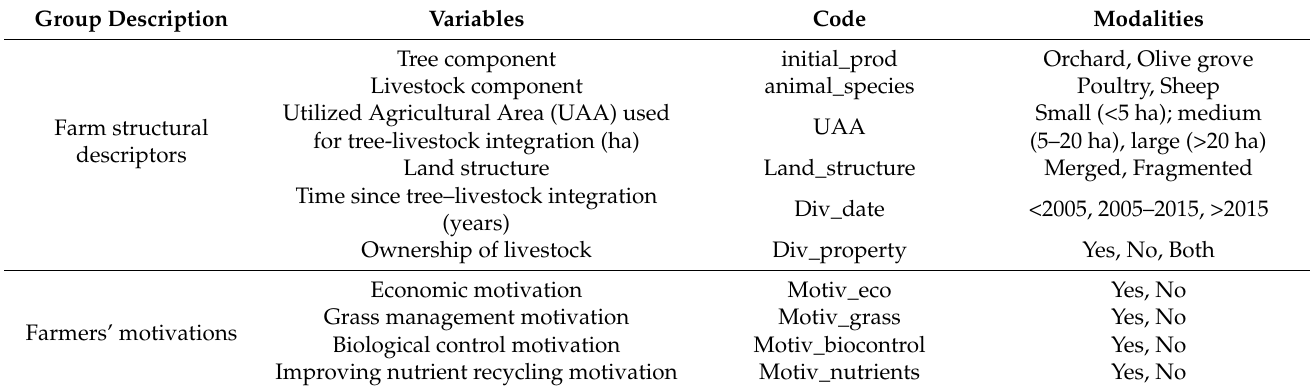
Table 1. Summary of variables and respective categories organized into